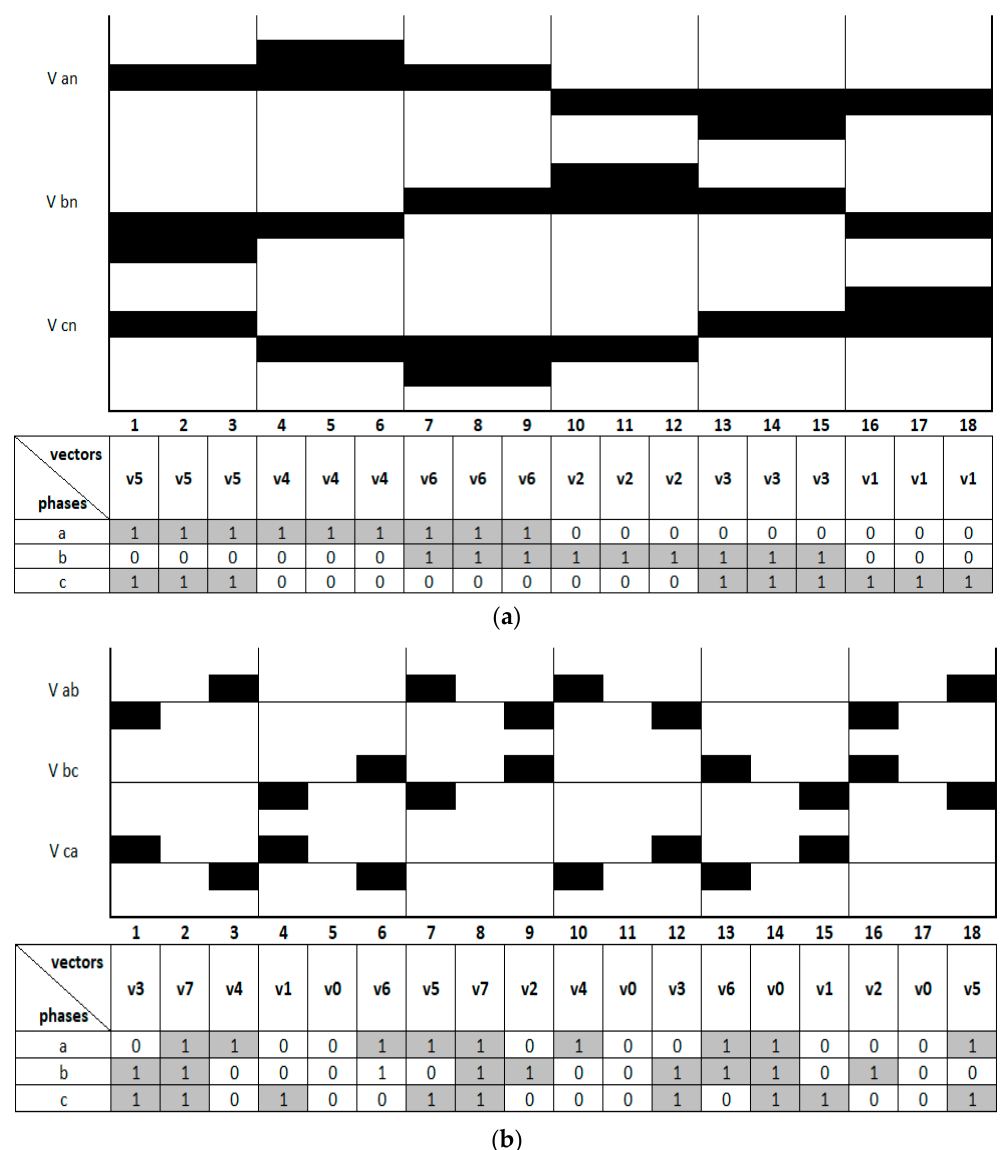
Figure 3. The theoretical waveforms (in black) of the phase-to-phase voltages corresponding to the control vectors for the main ( a ) and auxiliary inverters ( b ).